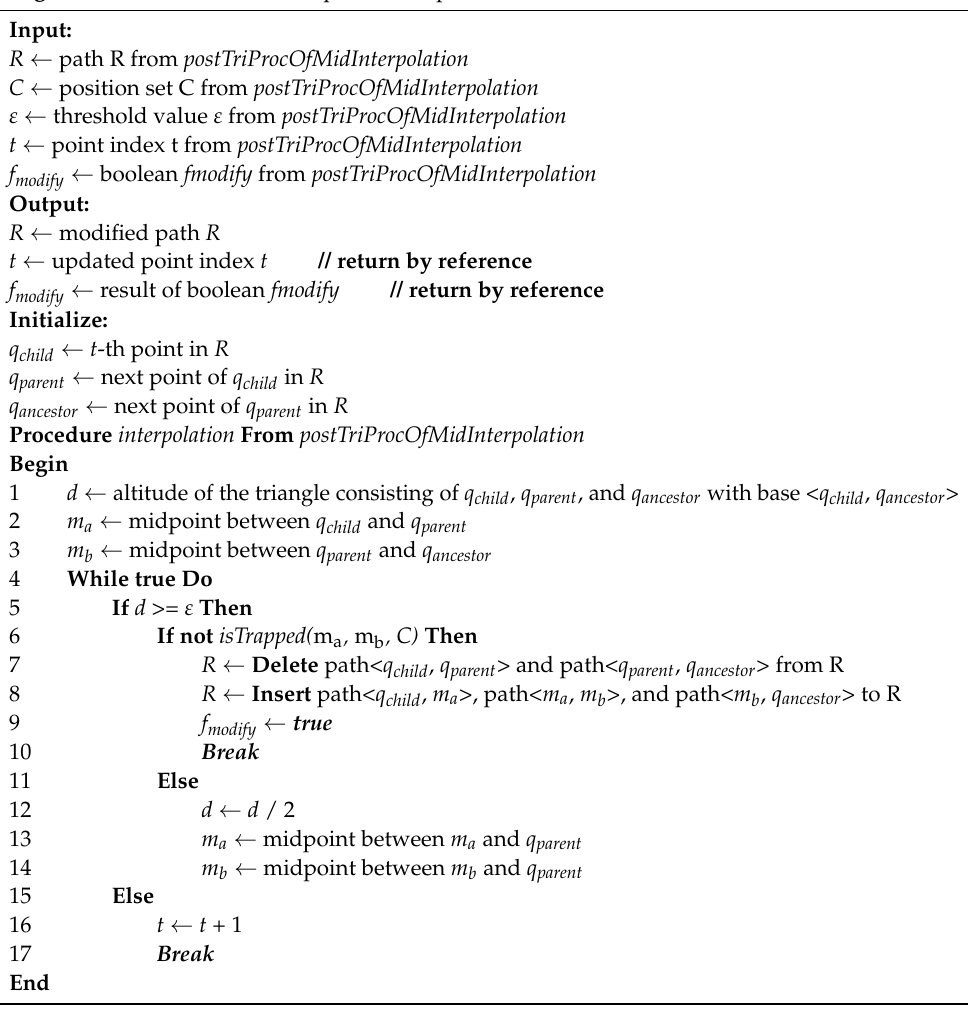
Algorithm 5 Pseudocode of Proposed Interpolation